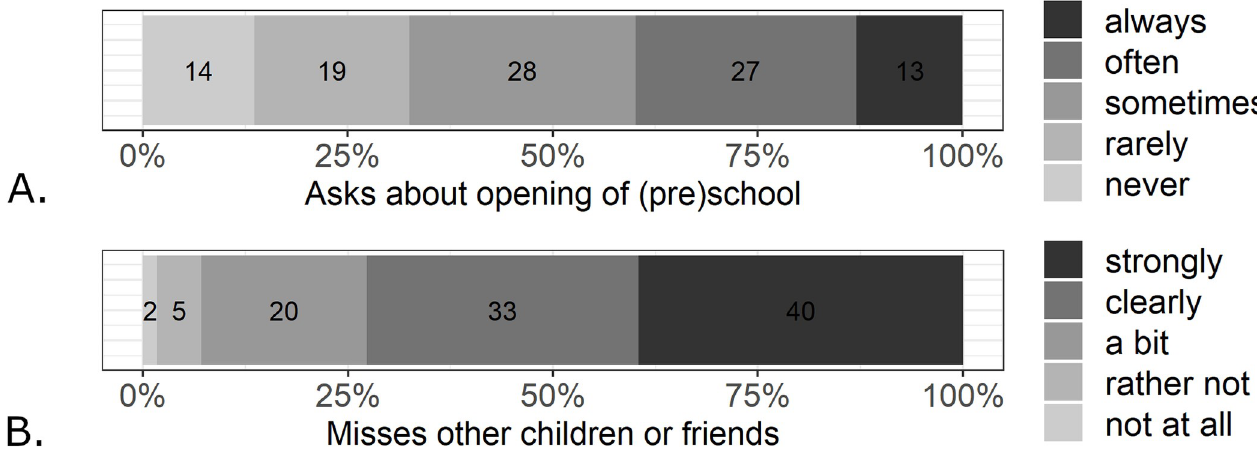
Fig 3. A: Frequency of children asking about the opening of their (pre)school. B: Intensity of children missing other children from their (pre)school or other friendships.